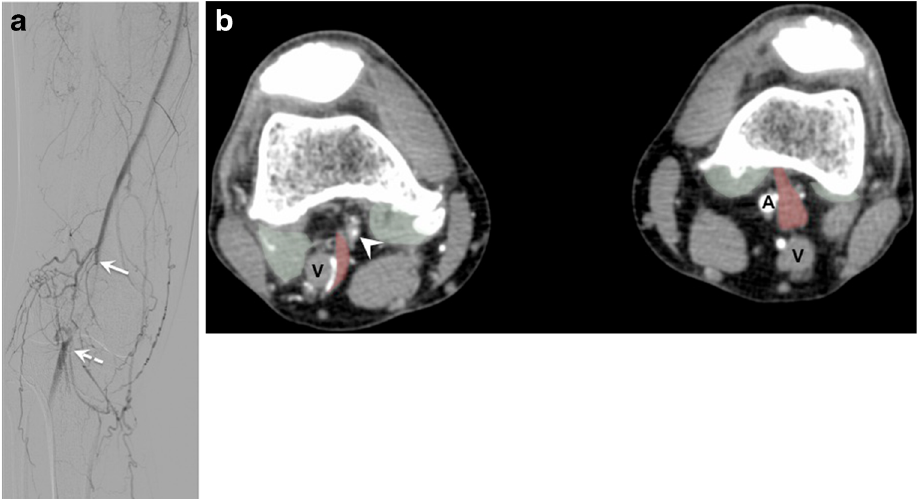
abnormal muscle slip ( red transparent overlap ) originating from the medial head of the gastrocnemius muscle and coursing between the popliteal vessels (V = popliteal vein). The contralateral side shows a similar appearance of abnormal muscle slip ( red transparent overlap ); however, the left popliteal artery is patent (A). Bilateral green transparent areas correspond to normal insertions of the gastrocnemius